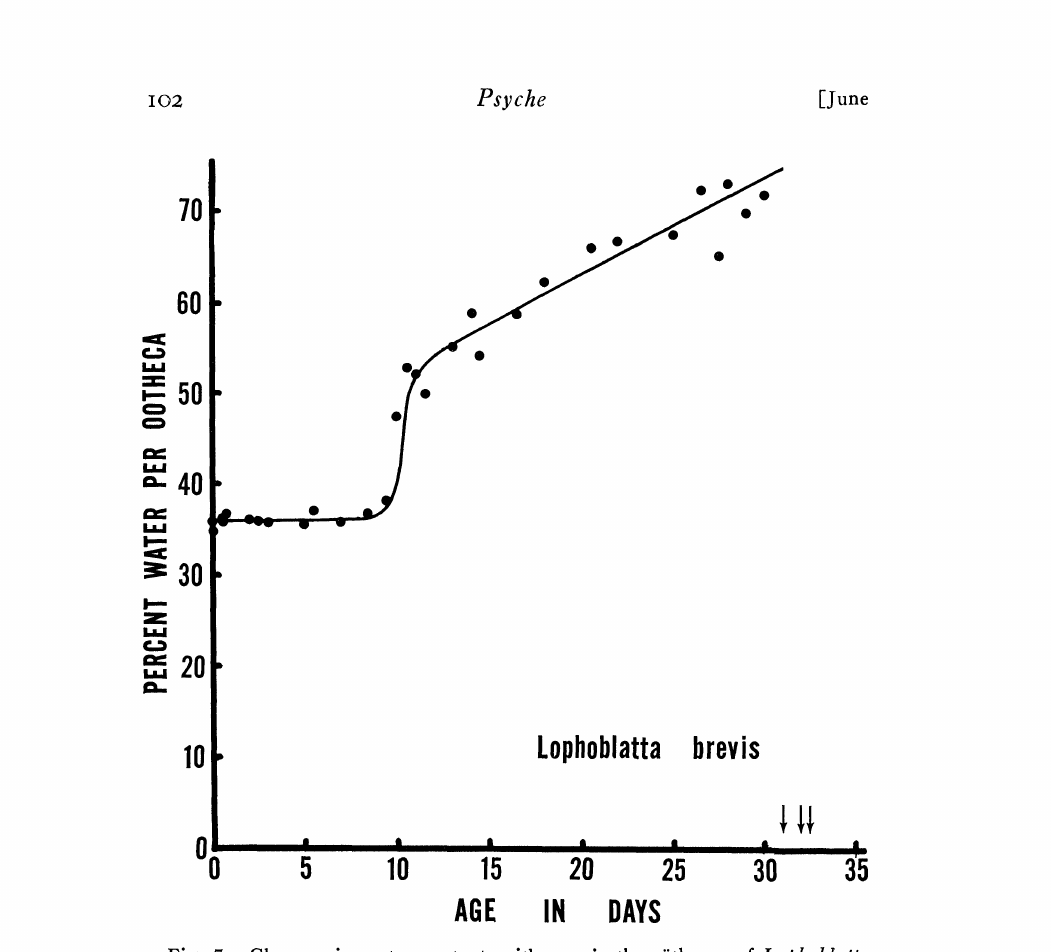
Fig. 7. Changes in water content, with age, in the o6thecae of Lolhoblatta breis. Arrows indicate days when eggs hatched. The first adults appeared in the culture in 84 to 85 days after the eggs hatched. After the first o6theca, oviposition occurs about every 4o to 44 days. If the o6theca is removed manually from the female prematurely, a new o6theca is formed much earlier than it would be if the eggs were allowed to remain attached to the female until hatching. The younger the age of the o6theca when detached from the female, the longer it takes to form a new egg case (Fig. 8). Recently formed o6thecae that are removed from the female lose water rapidly and the egg case collapses. These results are similar to those obtained with Blattella germanica (L.) and Blattella vaga (Roth and Stay, I96e) and show that the presence of an o6theca